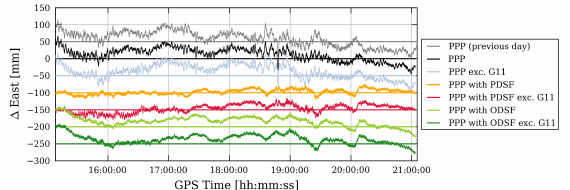
Figure 3: Easting errors between 15:17 and 21:04 (GPS system time) on August 31 2013 for receiver UEL resulting from standard PPP processing both with (black) and without (blue-grey) measure- ments from the satellite G11 on day 2. Similarly shown in other colors are the errors resulting from PPP processing with position- or observation-domain sidereal filters applied. Each of the time series have been offset from each other by appropriate multiples of 50 mm for